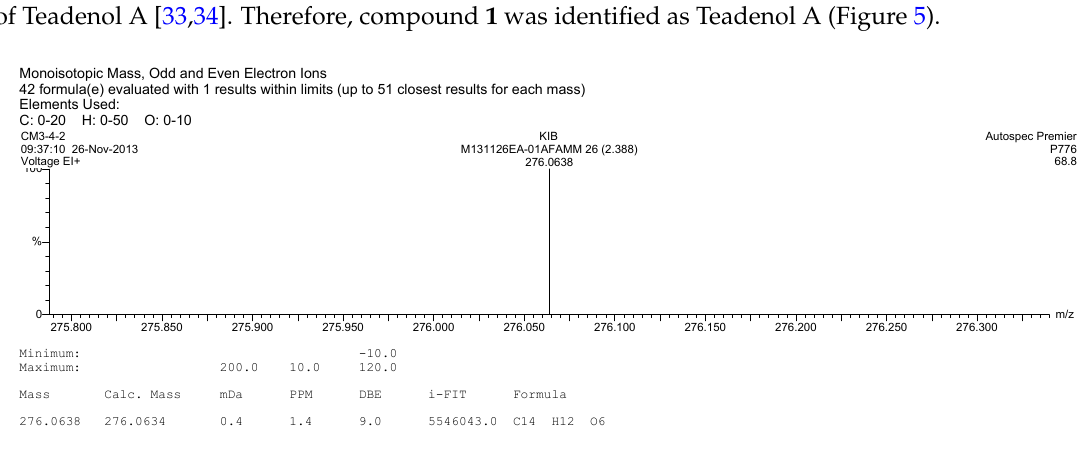
Figure 3. High resolution mass spectrometry assay of compound 1 .